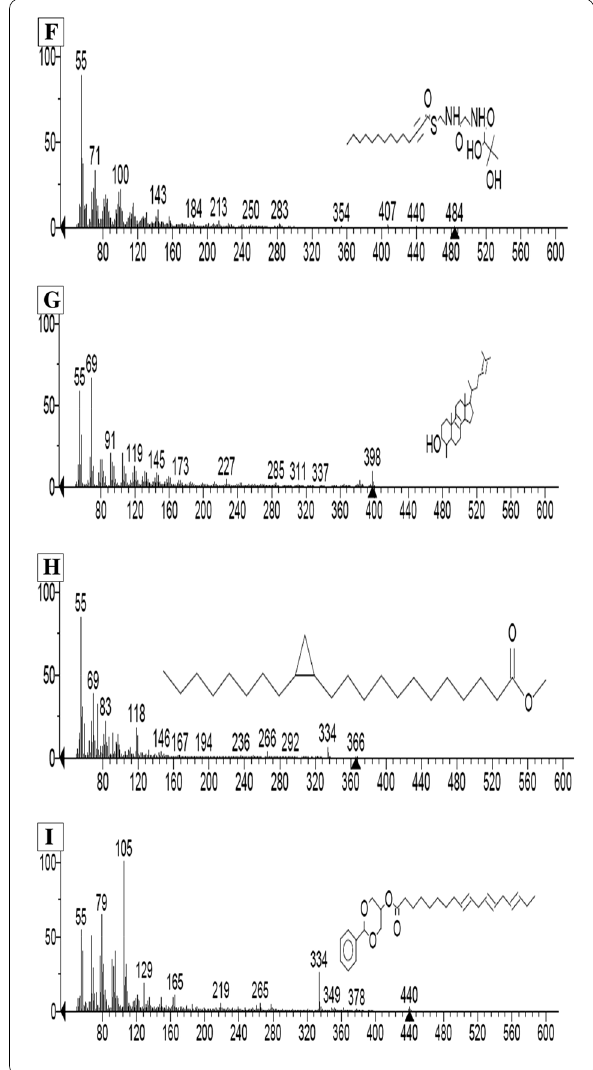
long period (14 days). The safe dose of 200 mg/kg bwt (which is the 10% of 2000 mg/kg bwt) was used to pre- treat the animals during oral glucose tolerance